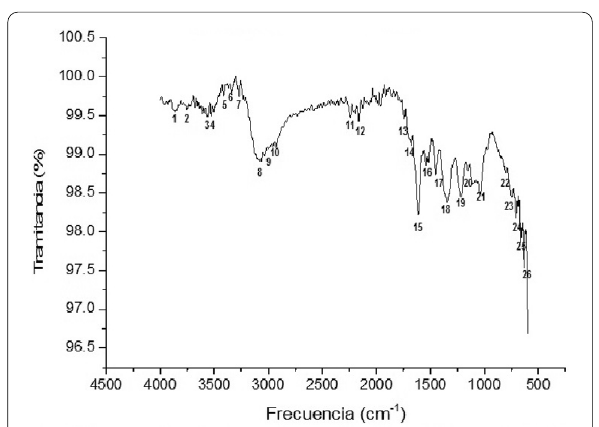
Fig. 4 FTIR spectra of SNP synthesized of L. coccinea leaf extract. Main peaks: 8 (16, 18) (22–26): aromatic (benzene with substitutions); 15(19): –COOH carboxylic (C